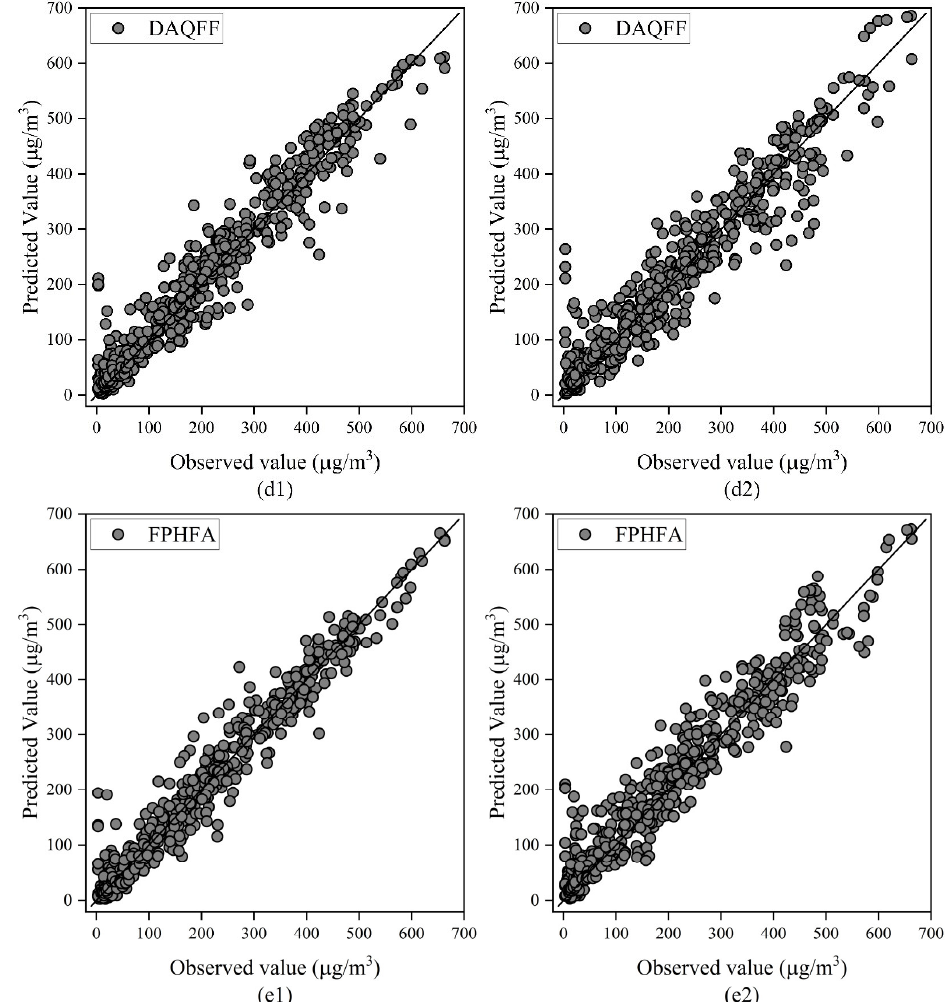
Figure 12. Degree of fit between the observed and predicted PM 2.5 value throughout the course of a month (16 December 2016–15 January 2017) with different models (LSTM, GRU, CNN-LSTM, DAQFF, and FPHFA) for prediction horizons of 24 h and 96 h, in experiments on the Beijing dataset. ( a1 ) LSTM model for prediction 24 h ahead; ( a2 ) LSTM model for prediction 96 h ahead; ( b1 ) GRU model for prediction 24 h ahead; ( b2 ) GRU model for prediction 96 h ahead; ( c1 ) CNN-LSTM model for prediction 24 h ahead; ( c2 ) CNN-LSTM model for prediction 96 h ahead; ( d1 ) DAQFF model for prediction 24 h ahead; ( d2 ) DAQFF model for prediction 96 h ahead; ( e1 ) FPHFA model for prediction 24 h ahead; ( e2 ) FPHFA model for prediction 96 h ahead.